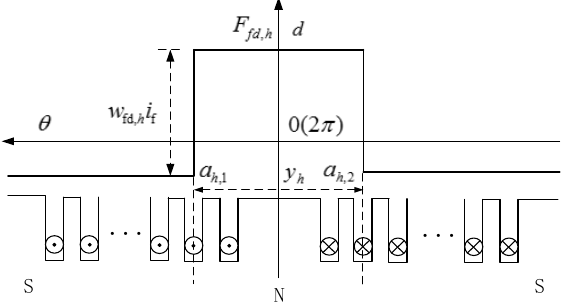
Figure 1. Magnetic motive force (MMF) produced by concentric field coil of field windings.